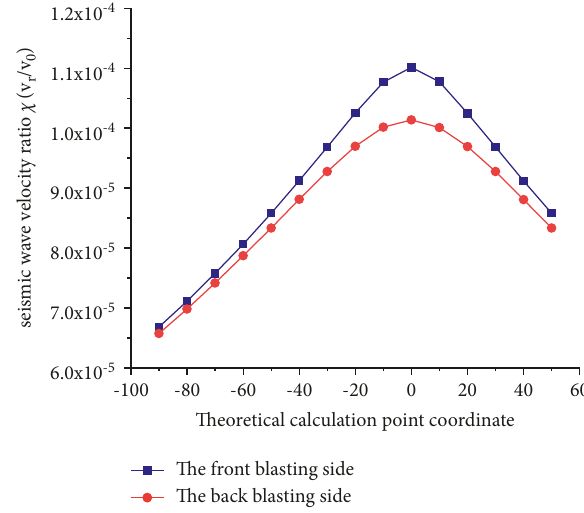
Figure 13: Variation curve of proportional coefficient χ